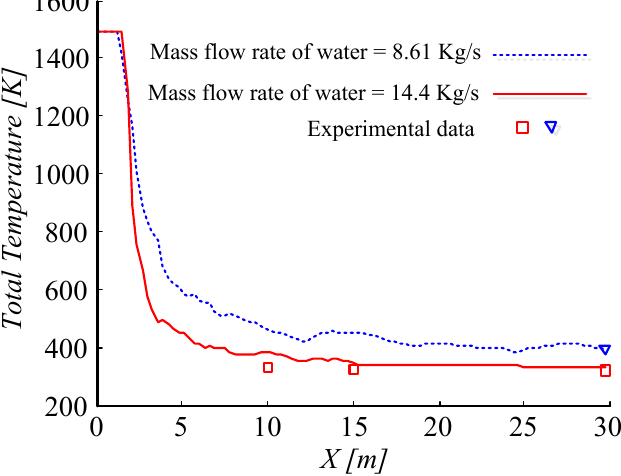
Figure 10. Comparison of total temperature between numerical and experimental data.